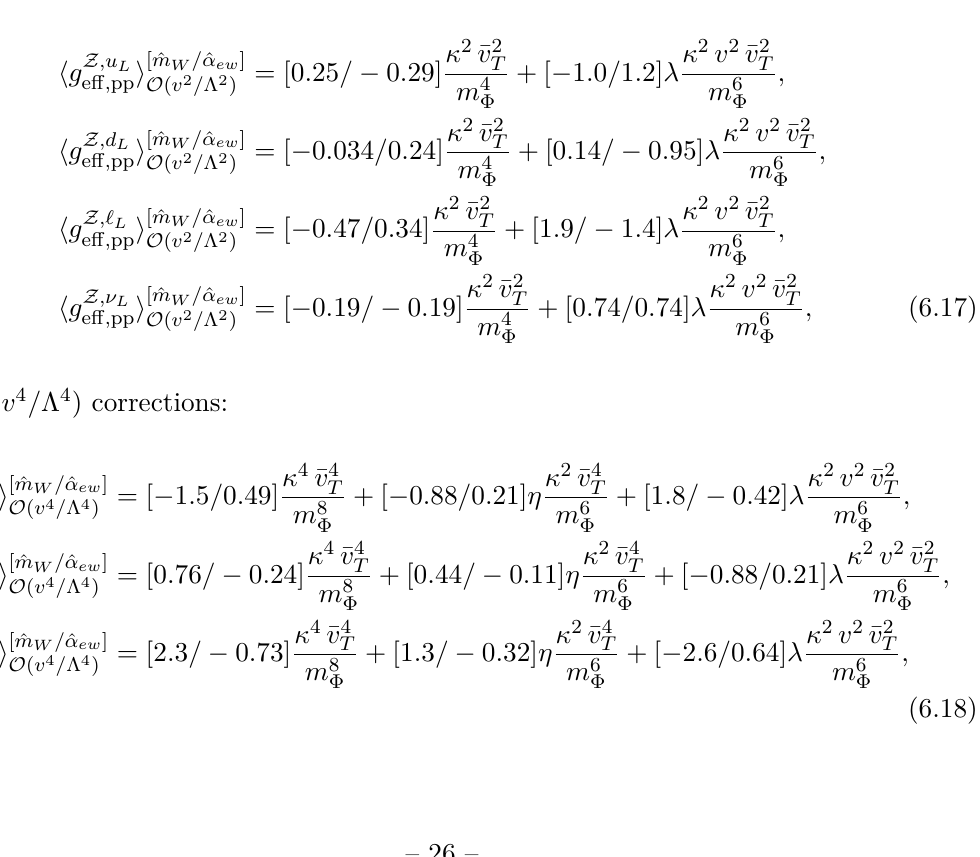
Figure 8 . Combined constraints from the full set of EWPD LEP observables in the U(1) mixing